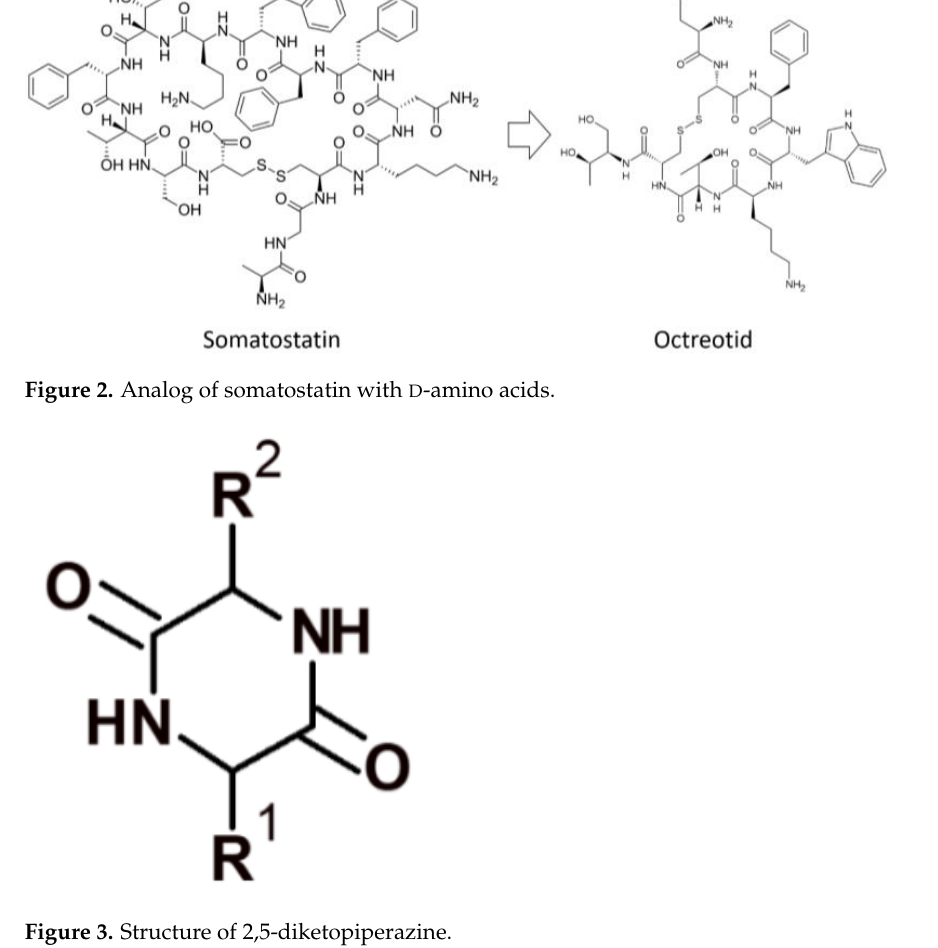
Figure 3. Structure of 2,5-diketopiperazine.